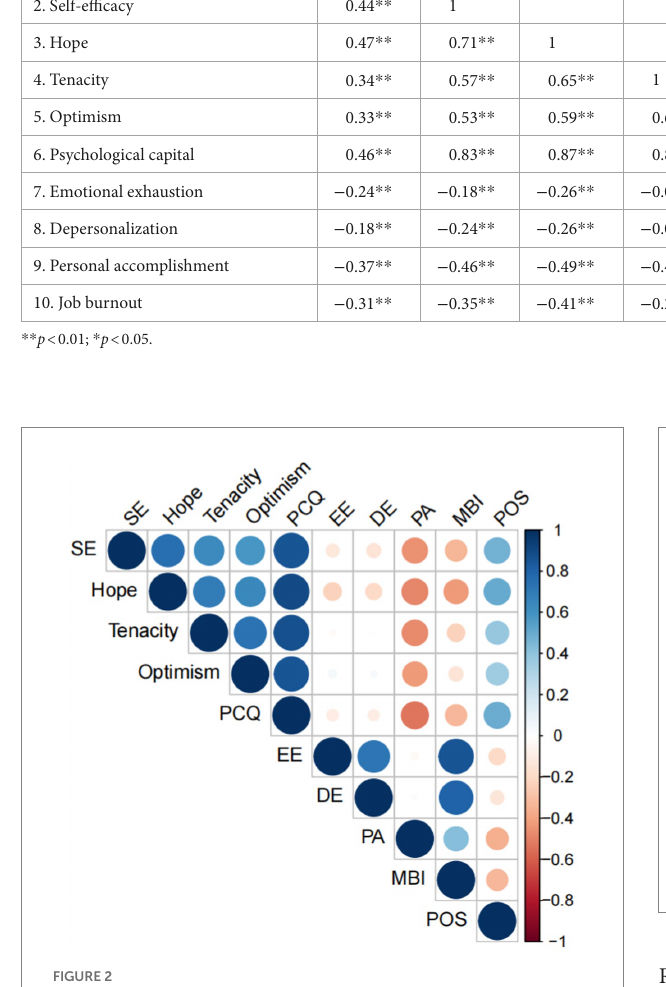
FIGURE 2 Heat map of psychiatric nurses’ job burnout, psychological capital, and perceived organizational support ( n = 916, Shandong, China). PCQ, Psychological Capital; POS, Perceived Organizational Support; MBI, Job Burnout; SE, Self-efficacy; EE, Emotional Exhaustion; DE, Depersonalization; PA, Personal Accomplishment.